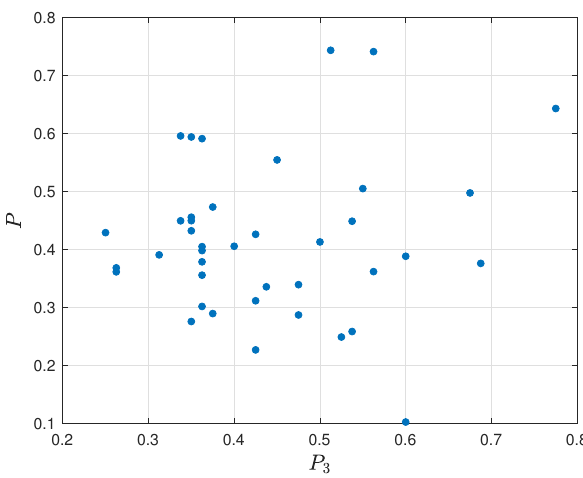
Figure 25. The relation diagram of the Failures per round assessment ( P 3 ) for final assessment P . ρ Spearman’s coefficient between the final model and reference ranking is equal to 0.5304, which means that both rankings are moderately correlated. The visualization of the relation diagram of final ranking P and Rating 2.0 is presented in Figure 26.